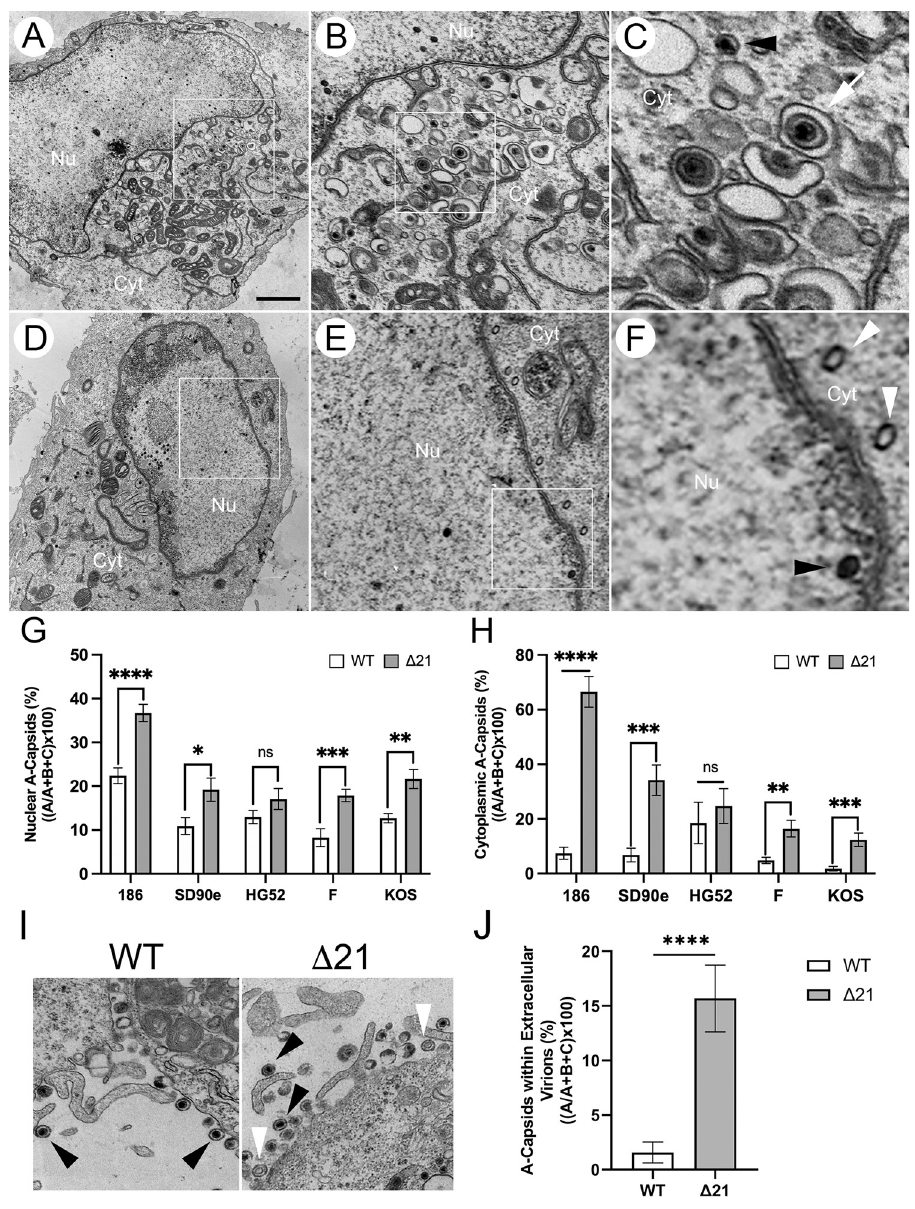
Fig 1. Nuclear and cytoplasmic A-capsid accumulation in HSV WT and Δ 21 strains. Vero cells were infected with either an HSV-1 or HSV-2 WT virus or its corresponding Δ 21 mutant at an MOI of 3. At 18 hpi, samples were fixed and prepared for TEM. Micrographs for each strain of HSV-1 and HSV-2 were obtained and WT and Δ 21 capsids in the nucleus and cytoplasm of infected cells were quantified. A-F) Example micrographs of HSV-2 SD90e WT (A, B, and C) compared to its Δ 21 mutant (D, E, and F) . As depicted in the Δ 21 panels ( E and F ), there is an abundance of A- capsids (white arrowheads) compared to the WT strain ( B and C ). Black arrowheads indicate C-capsids and white arrows indicate enveloped C-capsids. The 2 μ m scale bar applies to panels A and D . Panels B and E are three-fold magnified images of panels A and D . Panels C and F are three-fold magnified images of panels B and E . G) The quantification of nuclear A-capsids in cells infected with HSV WT and Δ 21 strains are depicted (n = 9–12 micrographs per condition). H) The quantification of cytoplasmic A-capsids in cells infected with HSV WT and Δ 21 strains are depicted (n = 11–14 micrographs per condition). I) Example micrographs of HSV-1 F WT and Δ 21 extracellular virions. As depicted in the Δ 21 mutant micrograph, there is an abundance of A-capsids within Δ 21 extracellular virions (white arrowheads) compared to the WT strain which has mostly C-capsids in extracellular virions (black arrowheads). J) The quantification of A-capsids within HSV-1 F WT and Δ 21 extracellular virions are depicted (n = 11–14 micrographs per condition). Unpaired t-tests were conducted between Δ 21 mutants and WT viruses. � , �� , ��� , and ���� represent p � 0.05, p � 0.01, p � 0.001 and p � 0.0001, respectively. ns = not significant.